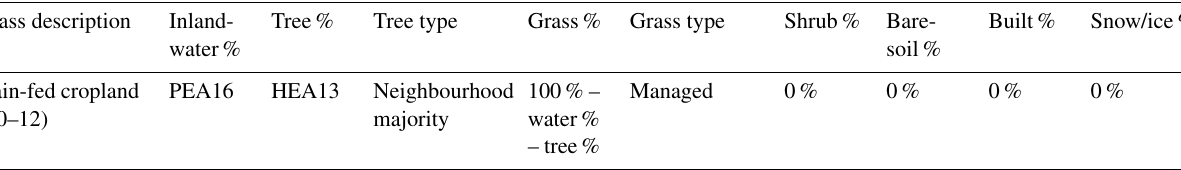
Table 2. Summary of the method applied to derive pixel-level functional type composition by land cover class. See Table 1 for more comprehensive class descriptions. PEA16: surface water data product of Pekel et al. (2016). HEA13: tree canopy cover product of Hansen et al. (2013). PEA13: Global Human Settlement Layer from Pesaresi et al. (2013). PEA21: tree canopy height dataset of Potapov et al. (2021). For the calculation of tree percentage, “Method 1” indicates that, in cases of disagreement in tree cover percentage between the ancillary dataset and the class legend, a window of up to 0 . 5 ◦ × 0 . 5 ◦ is used to estimate the final tree cover percentage based on neighbourhood pixels of the same class, and “Method 3” indicates that an upper limit of 14% tree cover is applied based on the class definition. See the text for additional details on the processing and use of the ancillary data products, the method used to align the derived PFT percentages with the class legend, the scaling method applied in cases where the sum of PFT percentages from the ancillary data exceeds 100% in a pixel, and the method used to derive the PFT fractional composition for pixels falling outside of the extents of the ancillary datasets. n/a – not